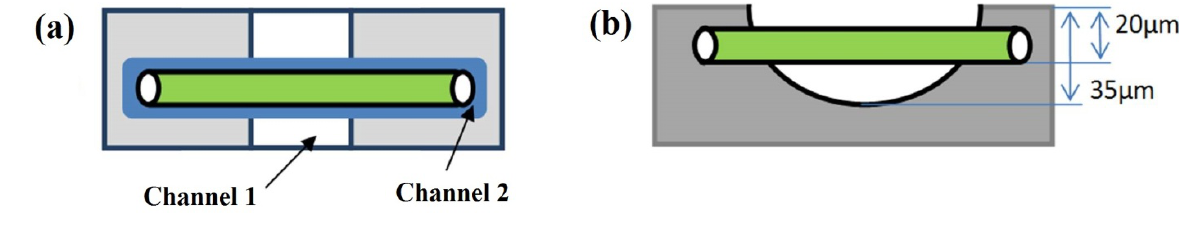
Figure 7. (a) Schematic representation in top view and cross-section view in (b) of the optimized